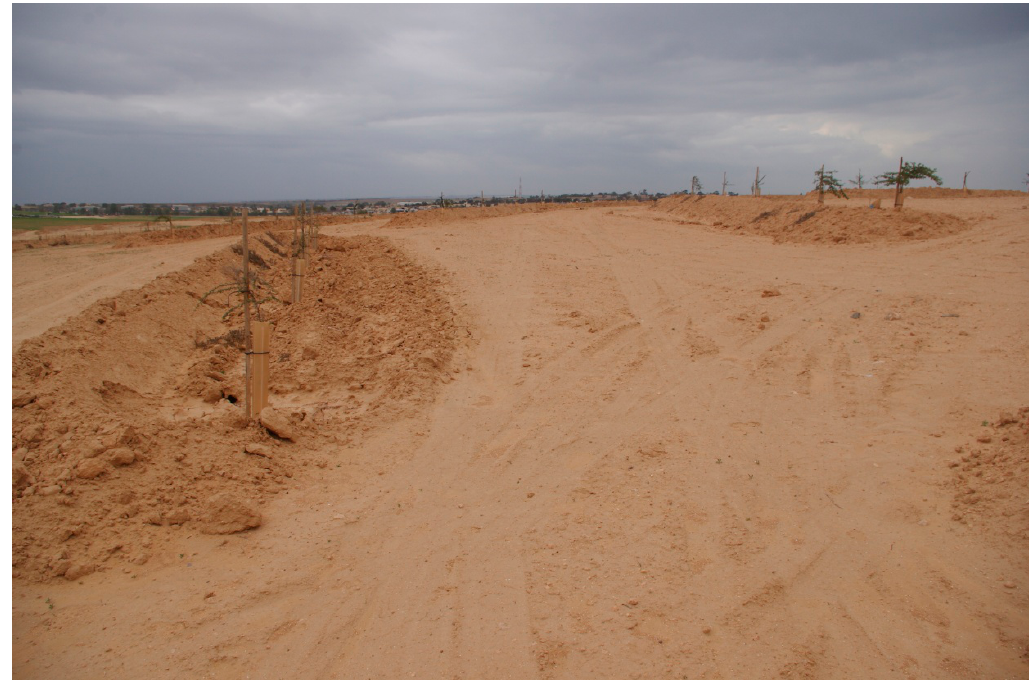
Figure 1. One-year-old contour bench terrace forestry system in the Israeli semi-arid northern Negev. Note the exposed and crusted ground surface of the inter-terrace space, from which topsoil was removed and utilized to construct the terraces. Photo taken by I. Stavi in winter 2018/19.